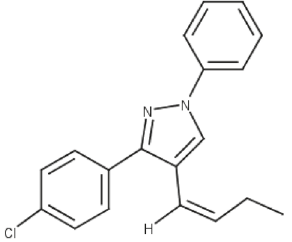
FIGURE 18 - Phenylpyrazole derivative that can inhibit the enzymes AChE and MAO A and